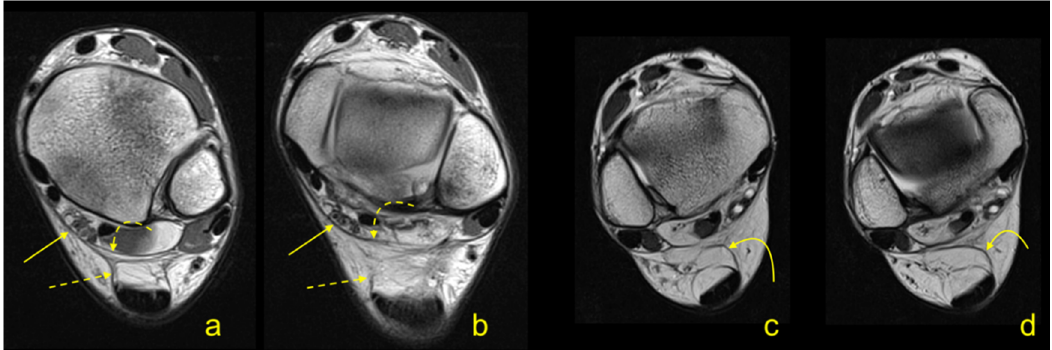
Figure 6. ( a , b )—a 38-year-old patient with clinical suspicion of chondropathy. ( c , d )—a 31-year-old patient with clinical suspicion of a ganglion. ( a – d )—PD weighted images. FR (straight arrow) communicates with FTCL (curved dashed arrow). Communication between FR and the paratenon (dashed arrow) is visible on ( a , b ), but on ( c , d ), the paratenon receives projection only from FTCL (curved arrow).